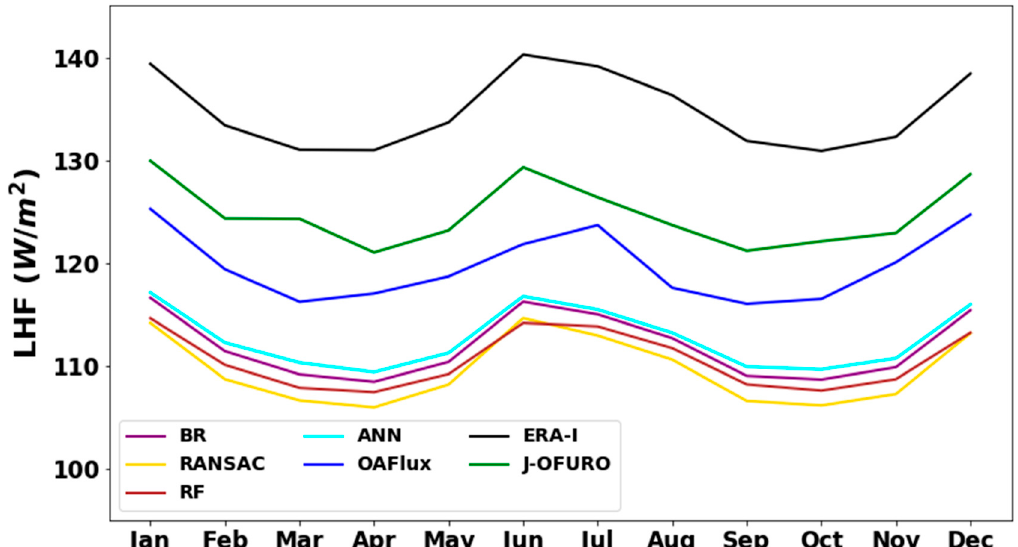
Figure 14. Annual variation of annual average LHF over low-latitude regions during the period of 2003 to 2007 (unit W m − 2 ).